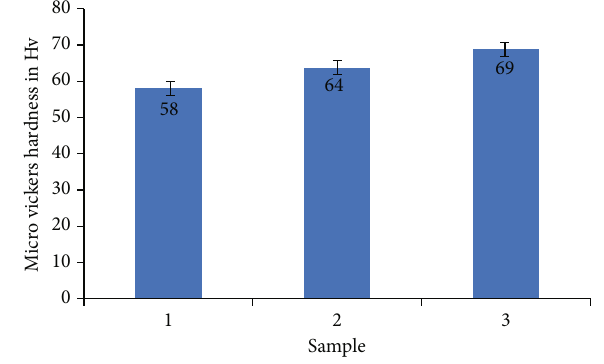
Figure 3: Micro Vickers hardness for copper hybrid